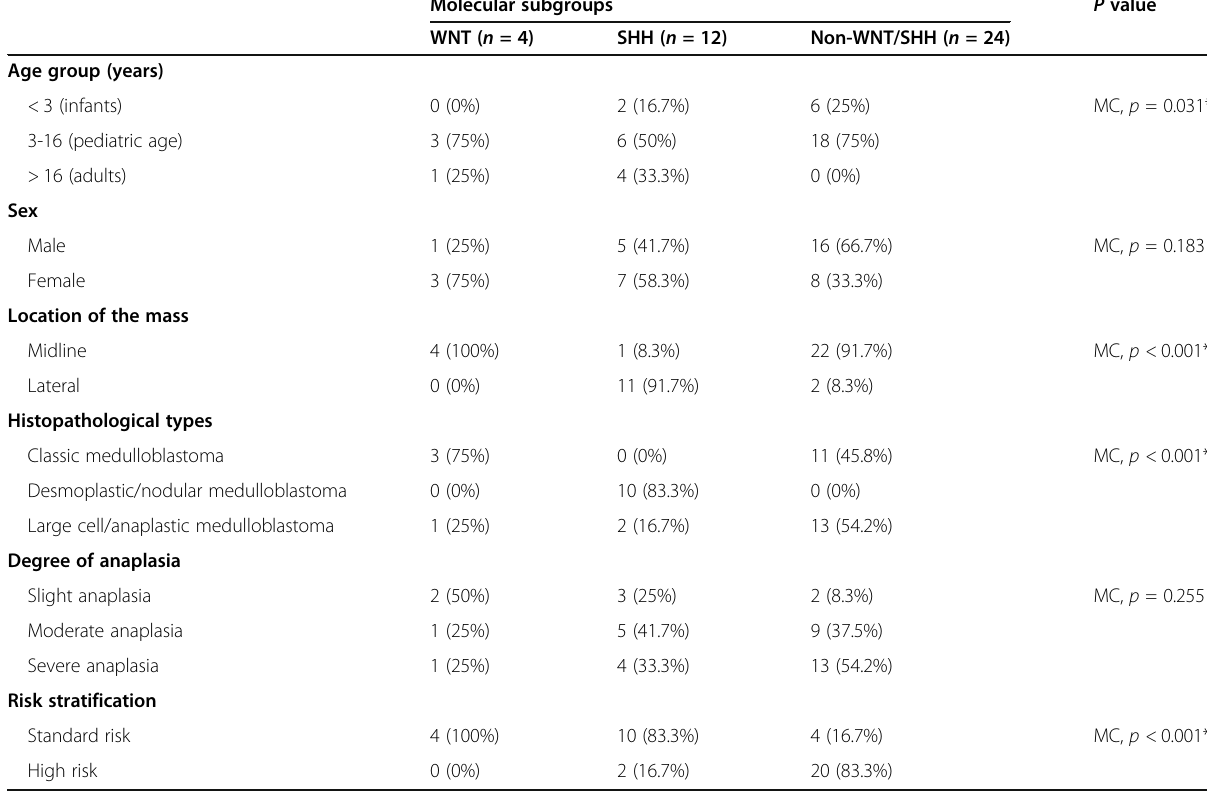
Table 4 Relation of molecular subgroups to clinicopathological parameters Molecular subgroups